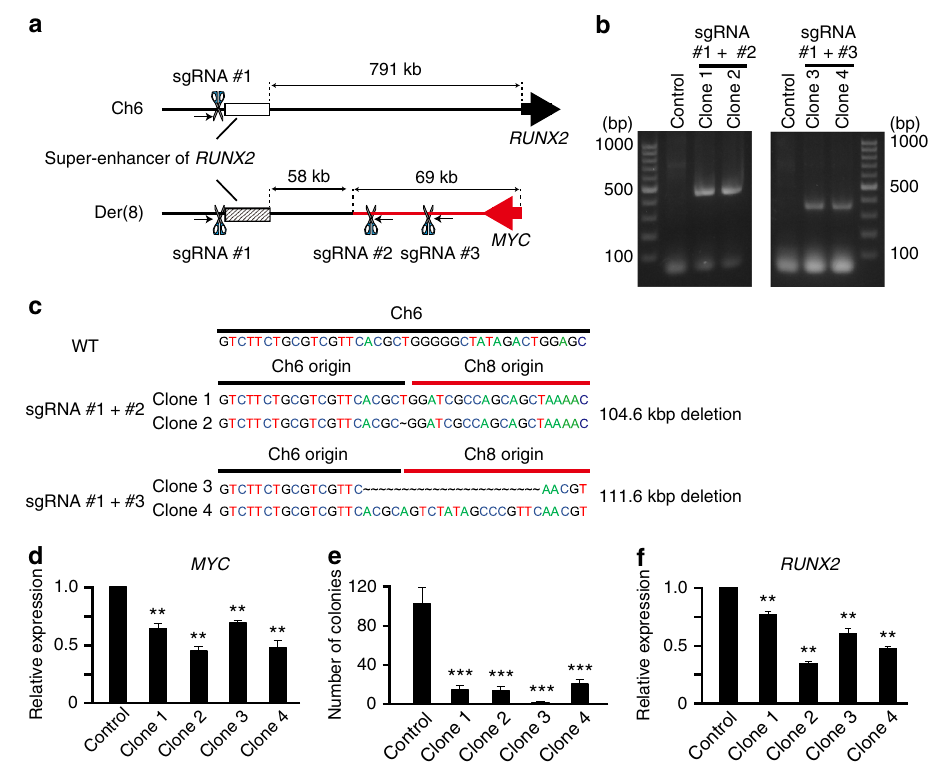
Fig. 5 RUNX2 super-enhancer-driven MYC expression promotes the formation of BPDCN. a Schematic illustration of the RUNX2 super-enhancers on chromosome 6 (se RUNX2 (-791kb); a back line) and derivative chromosome 8 (se RUNX2 der8; a black and red fused line). sgRNA vectors were directed a distal region of the super-enhancer (sgRNA #1; chr6: 44,557,984-44,558,006) and two distinct downstream regions of MYC (sgRNA #2; chr8:128,812,545-128,812,567 and sgRNA #3; chr8:128,805,565-128,805,587). Arrows indicate primers for genomic PCR utilized in Fig. 5b. b Detecting successful deletions of the se RUNX2 der8 by genomic PCR using primers on distinct chromosomes of 6 and 8. c Sequences of se RUNX2 der8-deleted clones elucidated by Sanger sequencing and sizes of deletion in those clones. d Expression levels of MYC mRNA in se RUNX2 der8-deleted CAL-1 clones examined by q-PCR. e Impaired colony formation capacities in se RUNX2 der8-deleted CAL-1 clones from those in control cells ( n = 3). f Expression levels of RUNX2 mRNA in se RUNX2 der8-deleted CAL-1 clones examined by q-PCR. d – f Bars show the mean±SD, ** p < 0.01 and *** p < 0.001 by the Student ’ s t attempted to genetically delete the mutant-allele super-enhan- cer of RUNX2 on der(8) (se RUNX2 der8), but not that on chromosome 6 (se RUNX2 ( − 791kb)), in BPDCN cells using a